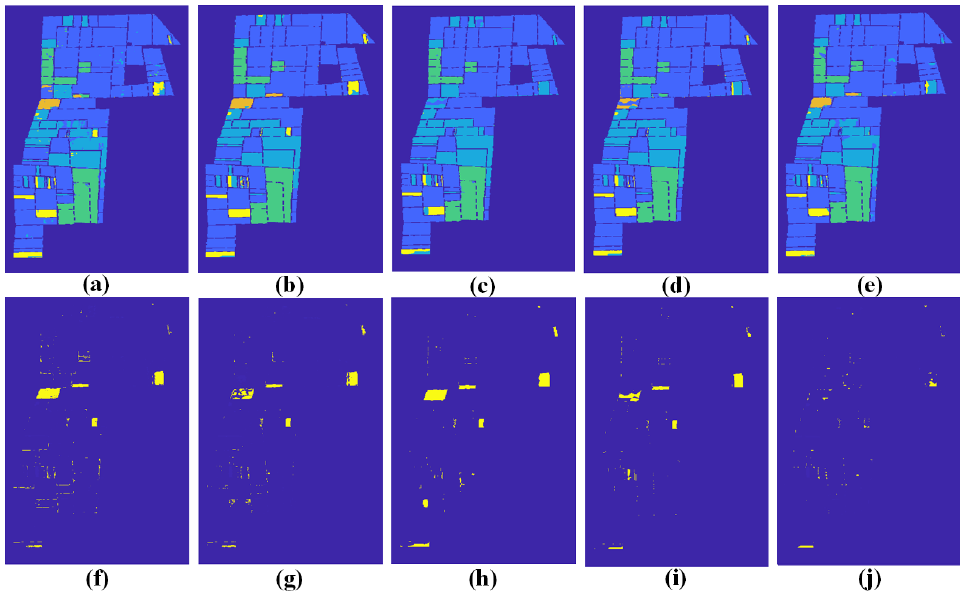
Figure 7. Classification result of different methods using polarization extension-fused data. ( a ) SAE- CNN, ( b ) 3D CNN, ( c ) 1D CNN, ( d ) LSTM, ( e ) FTDN; ( f – j ) the error maps of ( a – e